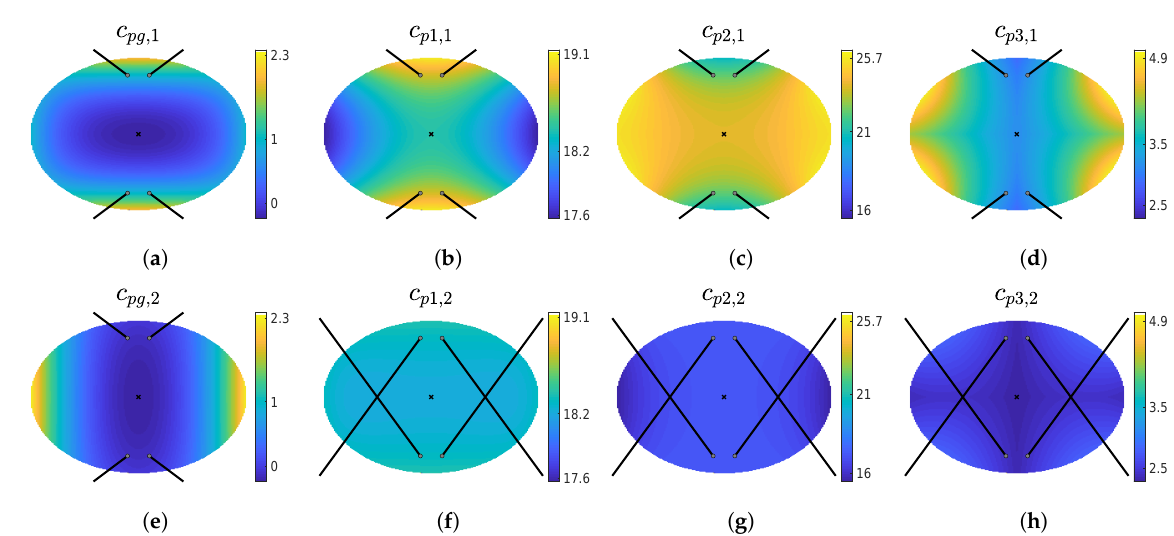
Figure 12. Cost maps for the terms of (8) for the two actuator configurations of Table 2 using (17) with κ x = 1 and κ y = 1. = 0 . Coloured area is N req,xy . ( a – d ) Actuator configuration 1. ( e – h ) The black lines represent cables configuration at η 3 Actuator configuration